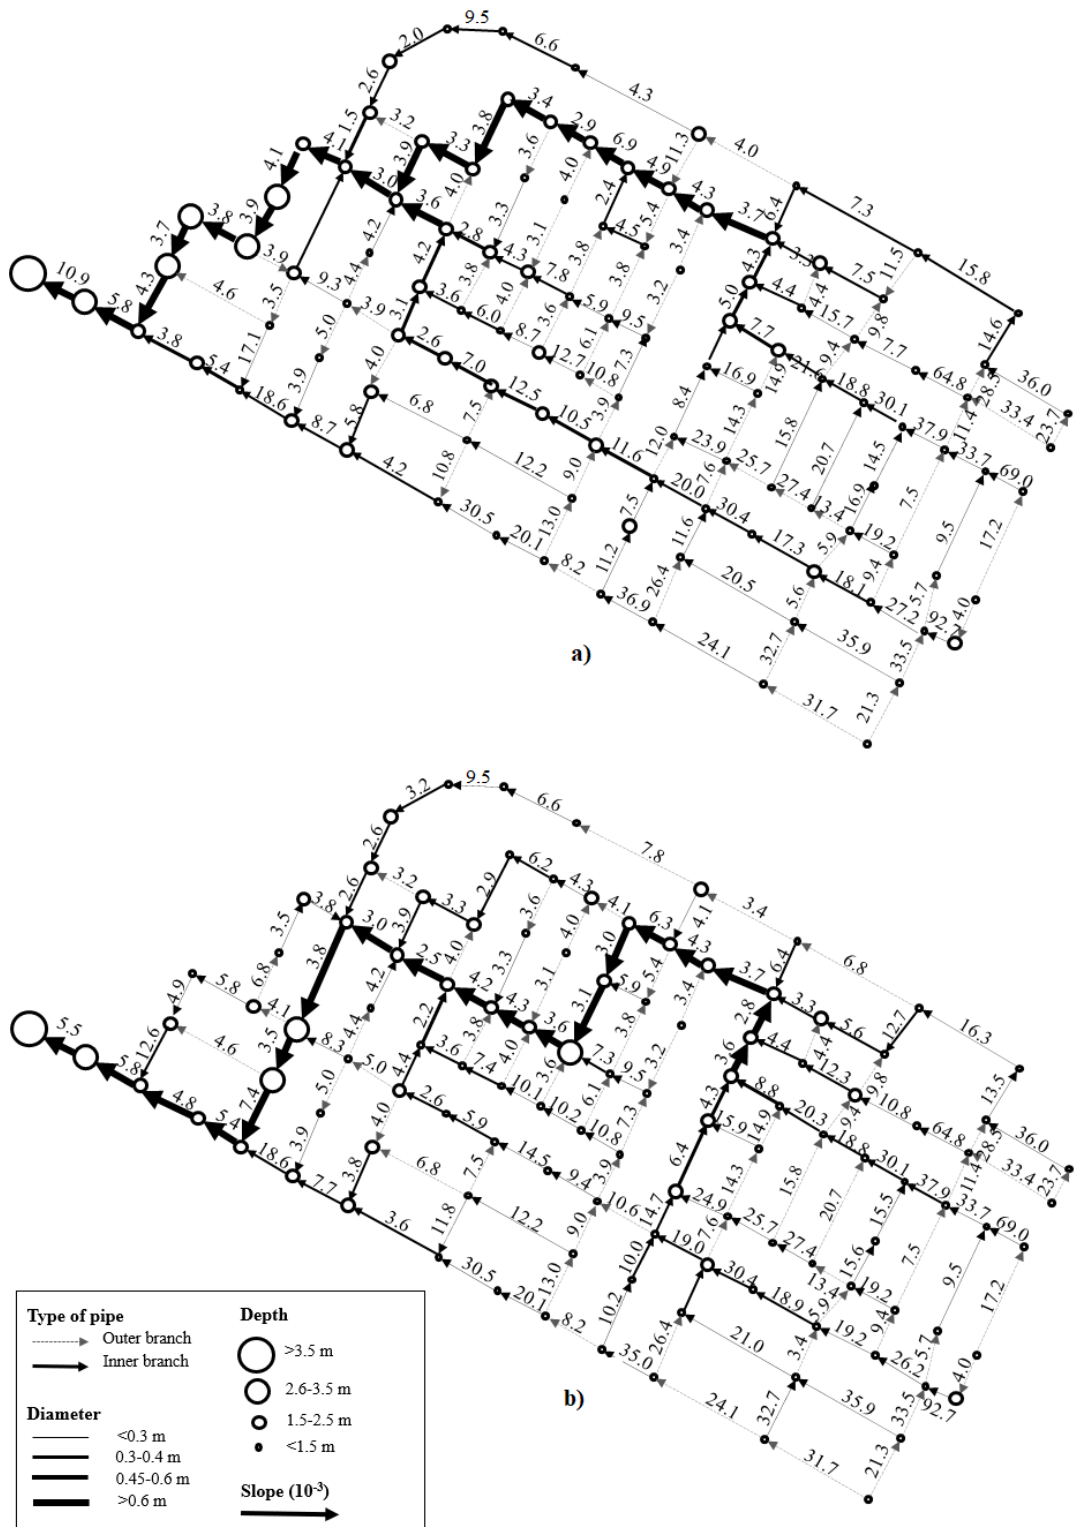
Figure 8. Scheme (not to scale) of the best design of the benchmark network proposed by Duque et al. [45] with ( a ) the cost function of Li and Matthew [34] and ( b ) the cost function of Maurer et al. [47].